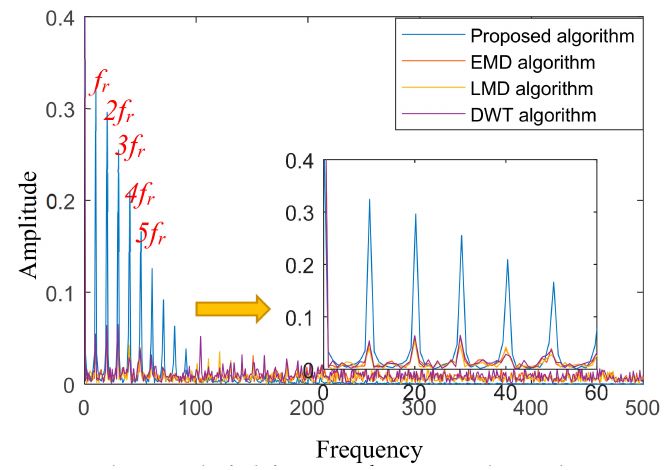
Figure 15. The fault features with square envelope